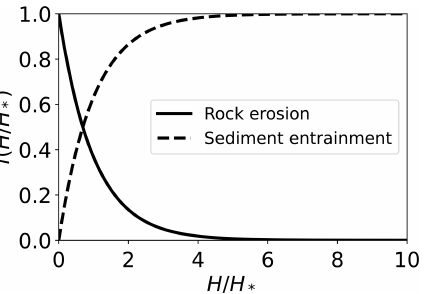
Figure 2. Relative efficiency of fluvial sediment entrainment and bedrock erosion, f (H/H ∗ ) , as a function of the ratio of sediment thickness to bedrock roughness H/H ∗ . f (H/H ∗ ) depends only on the ratio H/H ∗ , varies between 0 and 1, and indicates the propor- tion of total stream power used to entrain sediment – see Eq. 3; f (H/H ∗ ) = 1 − e − H/H ∗ (dashed line) – or erode bedrock – see Eq. 4; f (H/H ∗ ) = e − H/H ∗ (solid line). As sediment thickness H increases relative to the bedrock roughness length scale H ∗ , the sed- iment entrainment rate factor approaches 1 and the bedrock erosion rate factor approaches 0 because the bed becomes composed en- tirely of sediment, and no bedrock is exposed. As sediment thick- ness declines relative to the bedrock roughness length scale, the bedrock erosion rate increases exponentially because more bedrock is exposed, and the sediment entrainment rate declines exponen- tially due to a lack of available sediment. This approach imple- ments the “cover effect”, in which the presence of sediment reduces bedrock erosion rates but does not incorporate the “tools effect”, in which mobile sediment enhances bedrock erosion. Modified from Shobe et al. (2017).